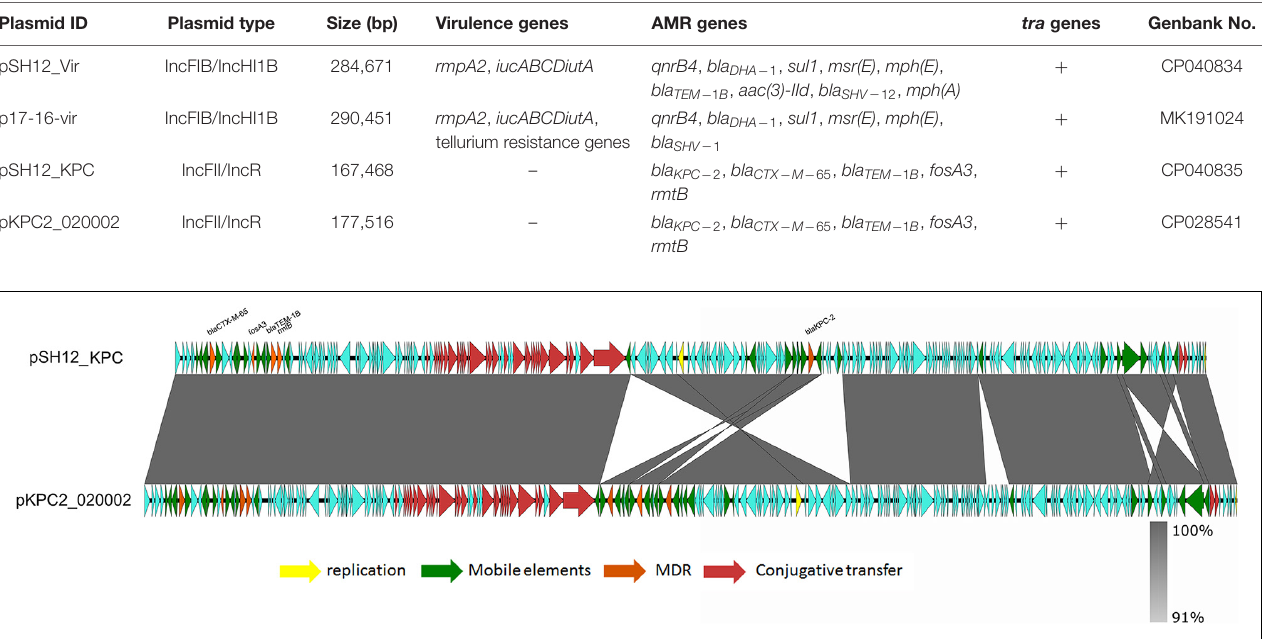
plasmid, pSH12_KPC ( Figure 2 ). Plasmid pSH12_KPC